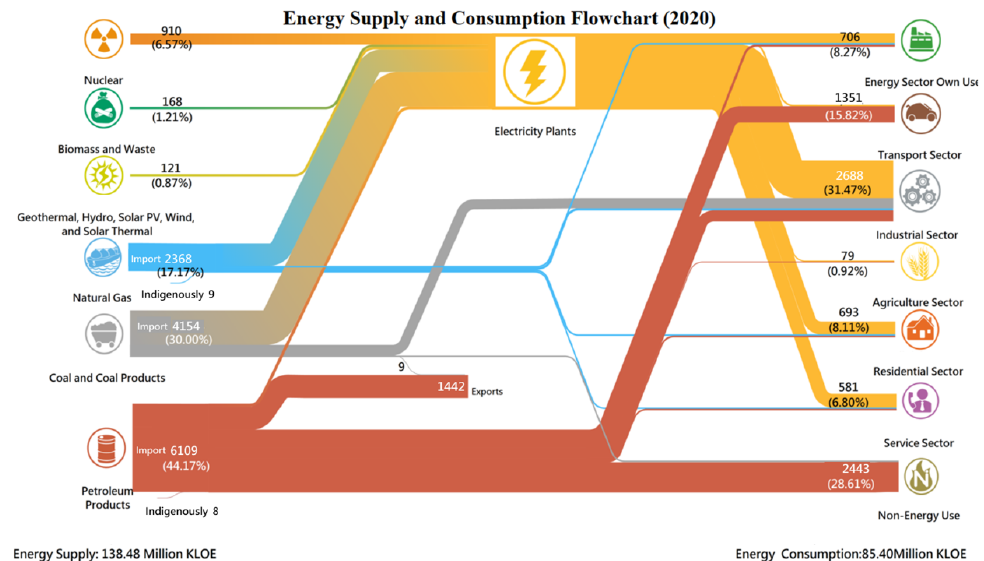
Figure 6. Energy supply and consumption flowchart 2020. Source: Bureau of Energy, MOEA.